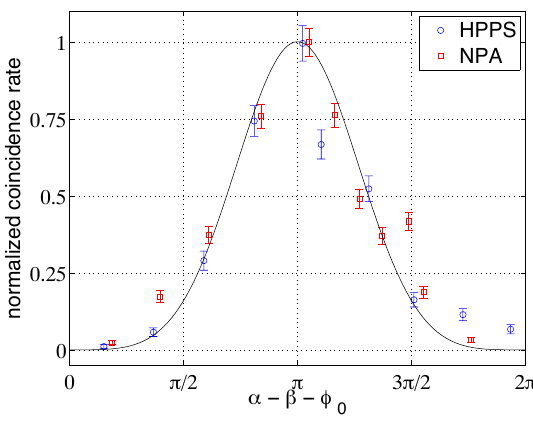
Figure 5: Two-photon interference pattern. Two-photon interferences obtained after photon–plasmon–photon conversion of one photon of the entangled pair through the HPPS or NPA. Symbols represent the experimental measurements. Vertical axis is the normalized net coincidence rate, i.e. the coincidence rate divided by the coin- cidence rate when modulation is off, with accidental coincidences subtracted. Statistical error bars are indicated. The horizontal axis is the phase α − β − ϕ 0 , when the phase α of Alice’s modulator is scanned, and when β and ϕ 0 are kept fixed. The RF amplitudes where adjusted to the values a ≈ b ≈ 1.2 in which case the coinci- dence curve has a single zero when α − β − ϕ 0 = 0 The continuous curve represents the theoretical predictions. The only adjustable parameter when fitting the theoretical prediction is the phase ϕ 0 which is